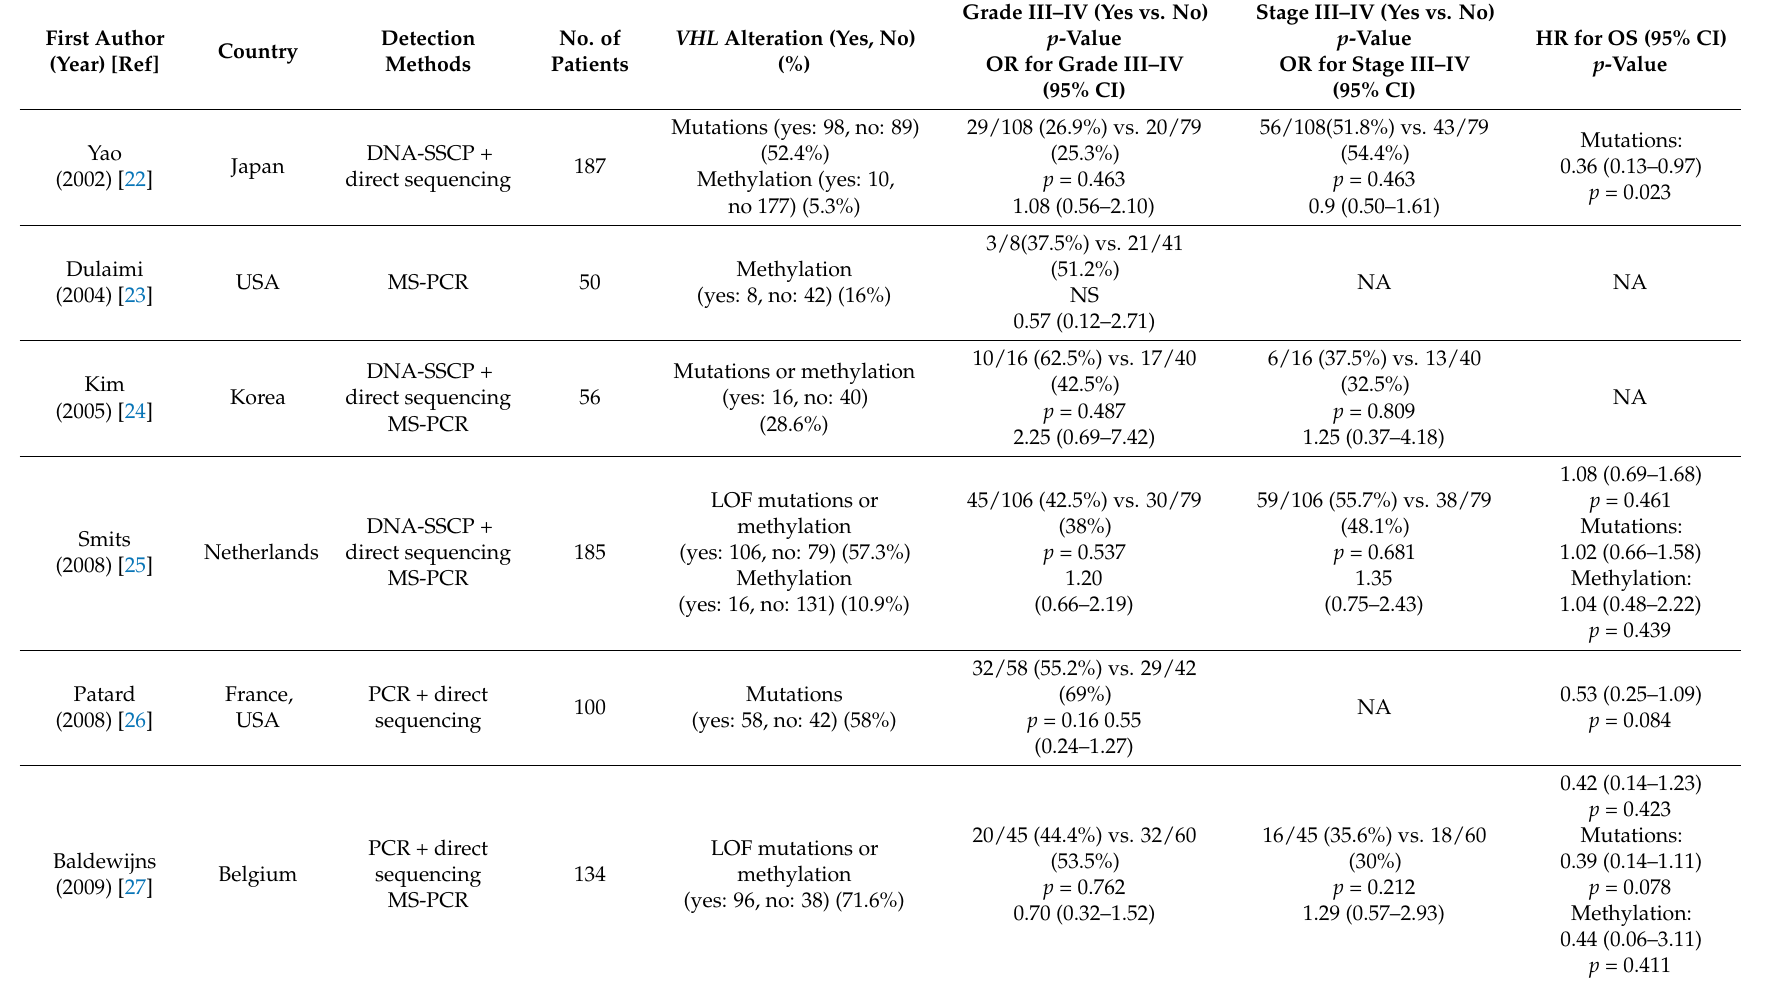
Table 1. Summary of the 10 included